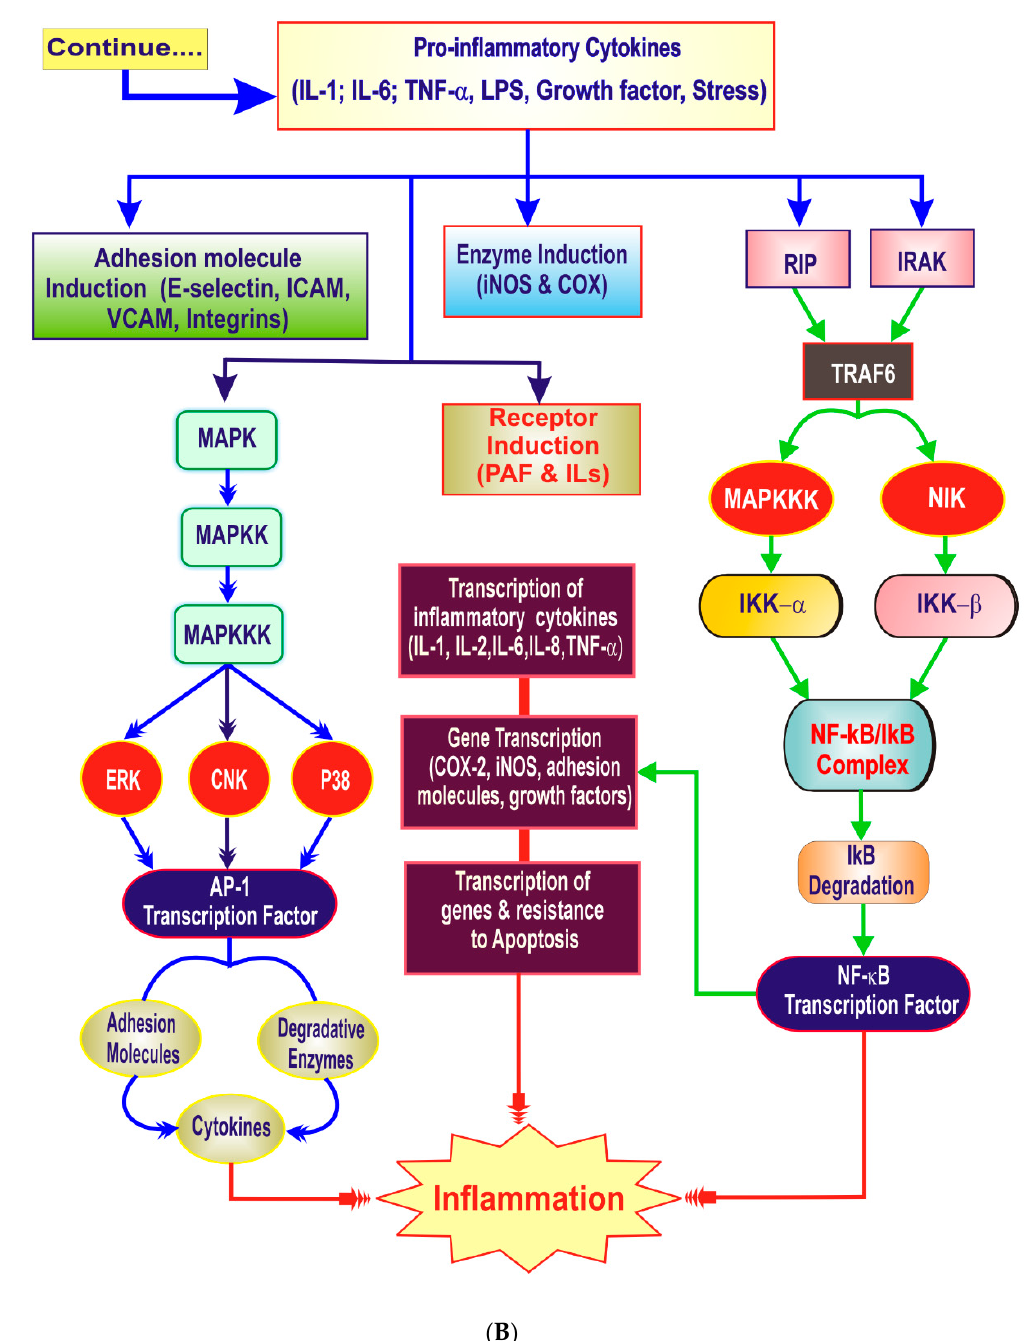
Figure 1. ( A ) The inflammatory cascade; ( B ) The inflammatory cascade. The arrows in the figure Figure 1 . ( A ) The inflammatory cascade; ( B ) The inflammatory cascade . The arrows in the figure represents process. The arrows in the figure represents represents process. The arrows in the figure represents process